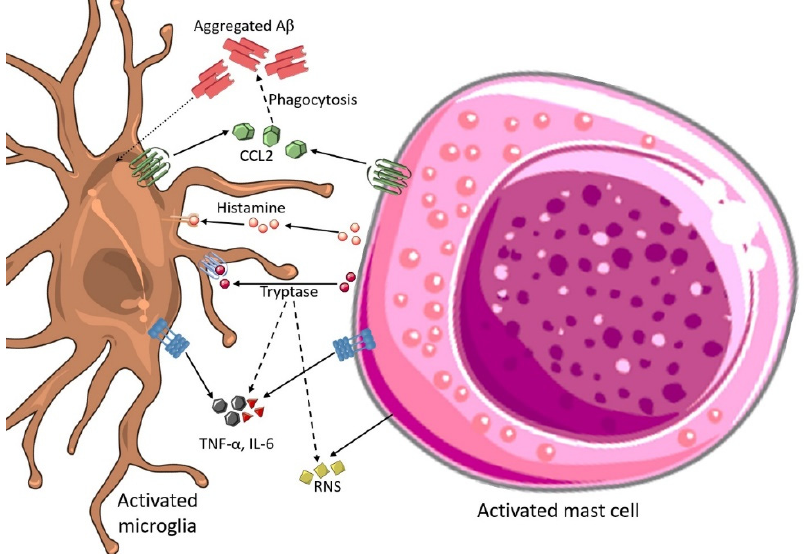
Figure 3. Activated microglia involved in the communication with mast cells in AD pathology. Murine N9 microglial cortical primary cultured microglia release RNS, IL-6,